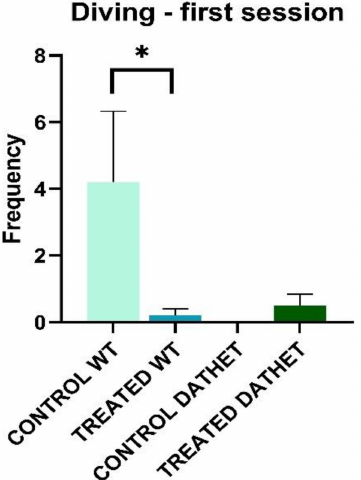
Figure 4. Forced swimming test was performed twice, in the morning and in the afternoon. The bar graph shows frequency of diving (0–150 s of morning session) for WT and DATHET control rats and rats treated with Moringa . Frequency was shorter in WT-treated subjects than water control subjects. Error bars represents standard errors of mean, SEM. * p < 0.05 compared to control